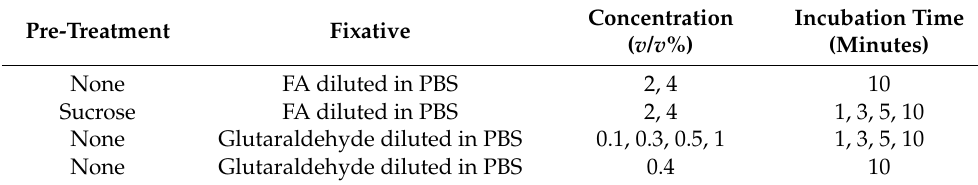
Table 1. Conditions evaluated to fix cells embedded in Matrigel. Pre-Treatment